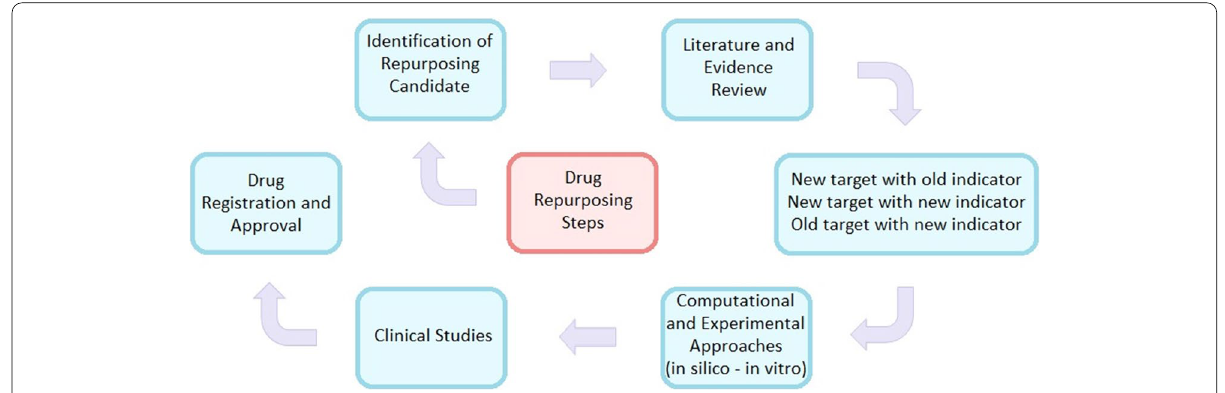
Fig. 1 Conceptual diagram of drug repurposing